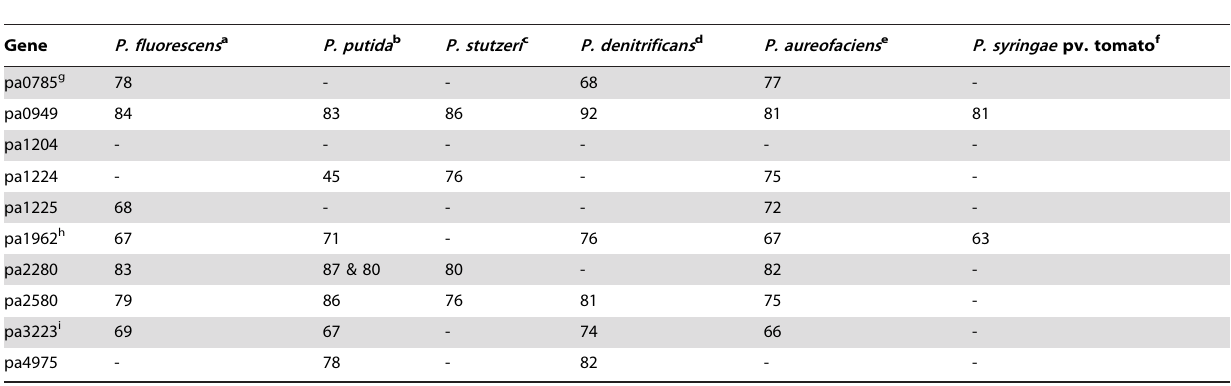
Table 3. Distribution of azoreductase-like enzymes across Pseudomonas